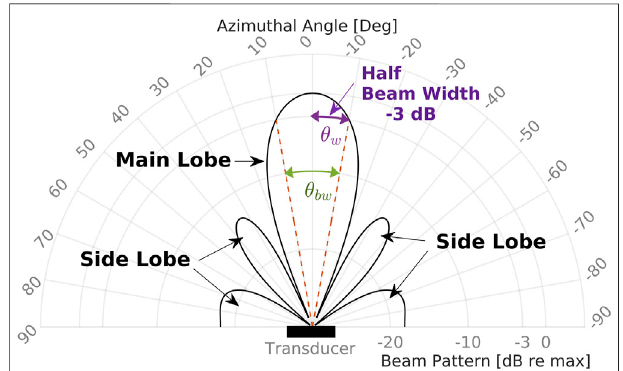
FIGURE 4 | Beam pattern schematics of half power beamwidth.